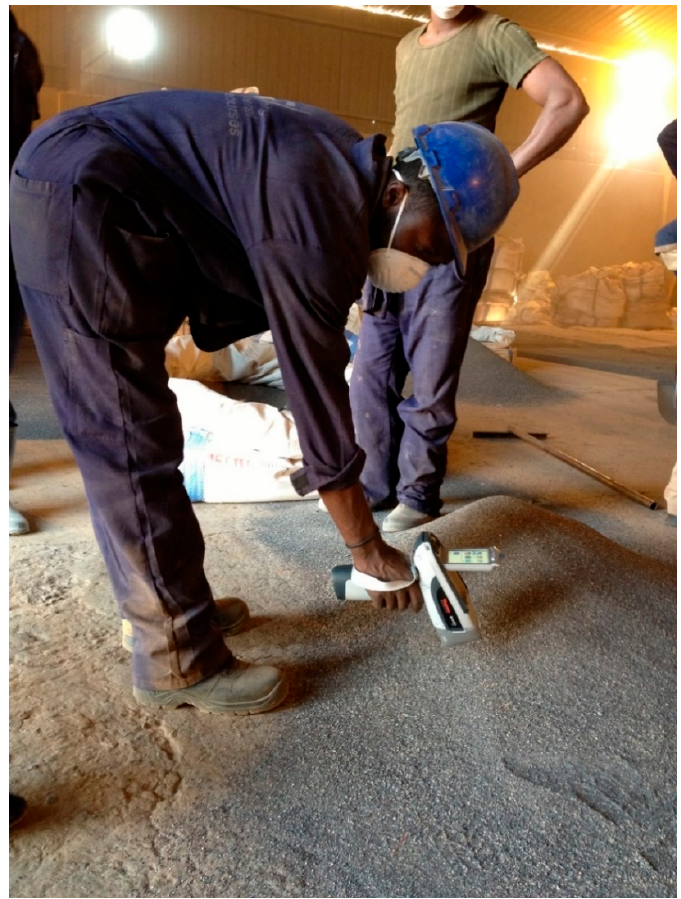
Figure 3. Analysis of coltan ore samples by HHXRF showing a real time qualitative test by the user. Table 3. List of elements provided by the handheld analyzer. Limits of detection (LOD in ppm), as well as certified standards used for the calibration of the handheld analyzer, are included. Elem. LOD Elem. Elem.